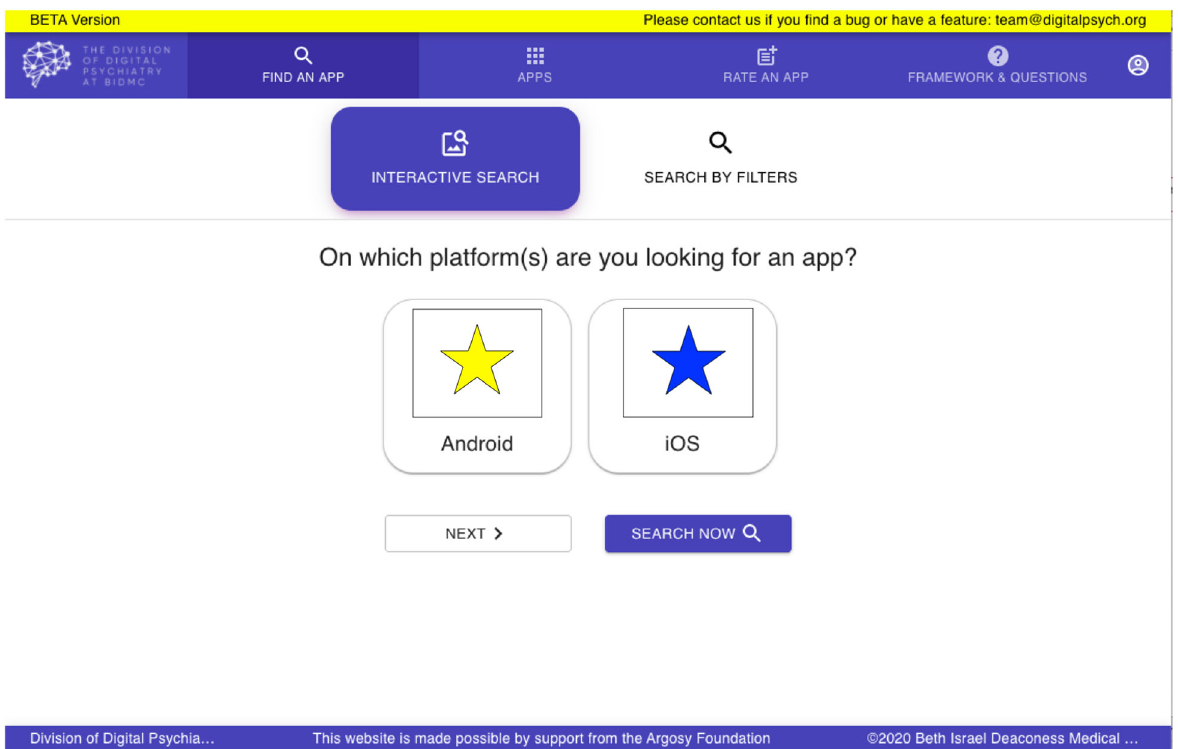
Fig. 2 Database Landing Page. The fi rst page that greets users is an interactive search for an app.